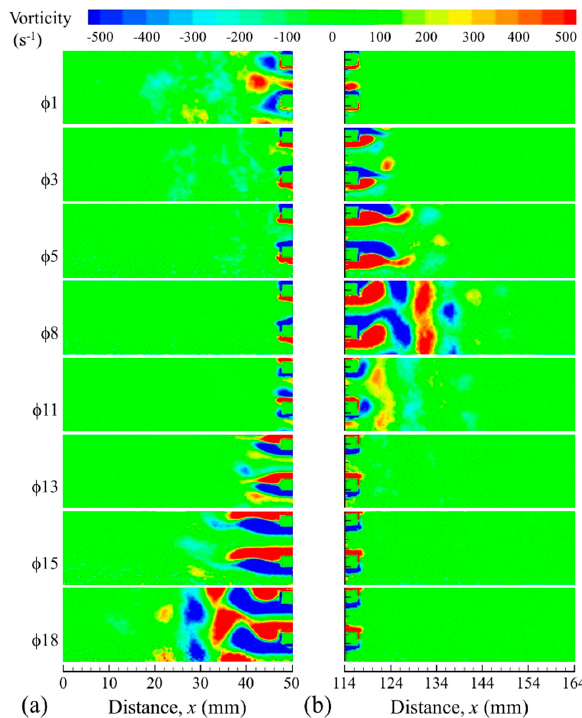
Figure 7. Vorticity contours at the left ( a ) and right ( b ) ends of the heat exchanger assembly calculated from the experimental results for the drive ratio of 0.83%. Arbitrary distance x is measured along the “viewing area”; vertical axis, y , is omitted for simplicity; the ratio of x : y is 1:1.